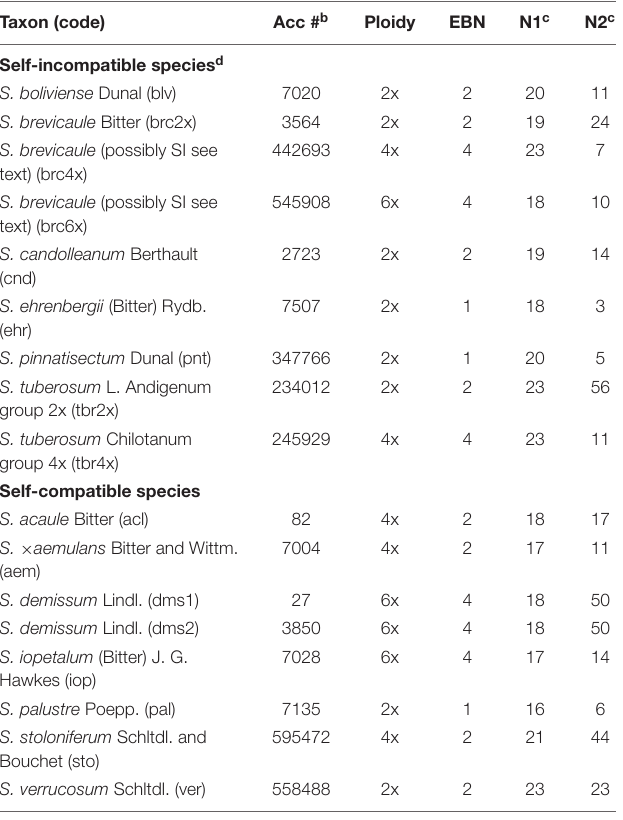
a Species codes correspond to Figure 1 . b The two- and four-digit accessions are from the Commonwealth Potato Collection (CPC) and the six-digit